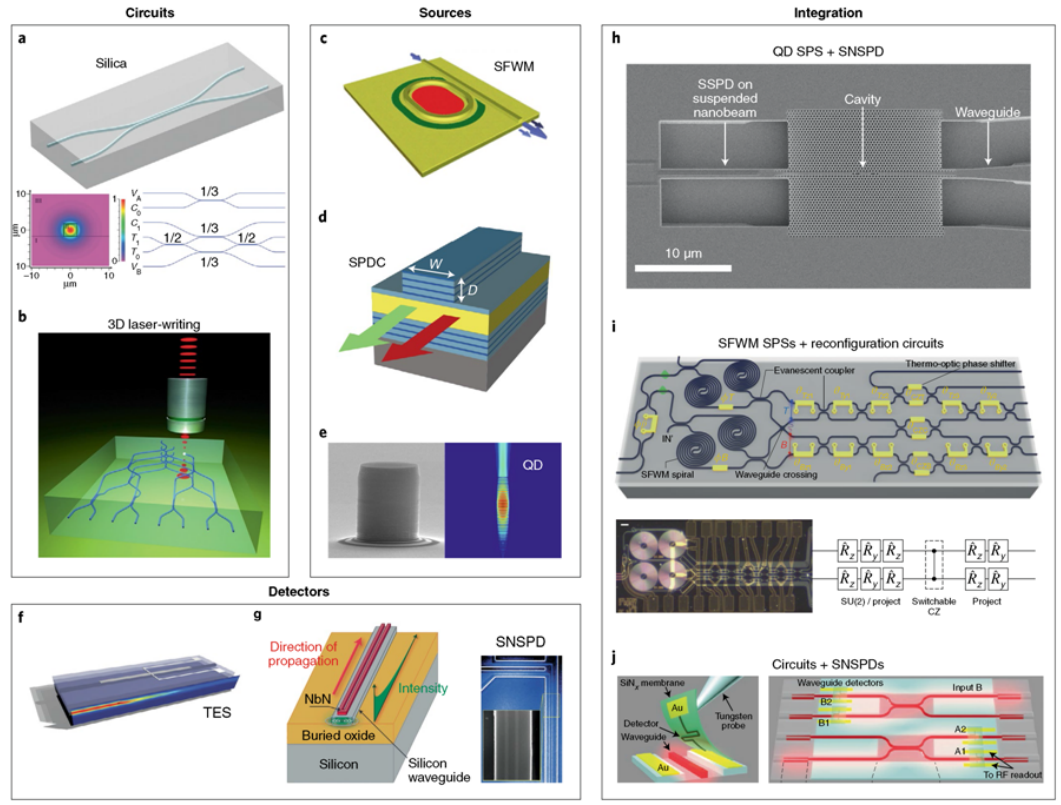
Figure 6. Integrated single-photon sources, detectors, and circuits. ( a ) The first IQP circuit for CNOT entangling gate in silica-on-insulator waveguides. ( b ) Laser writing quantum circuit in silica with complex 3D geometry. ( c ) An integrated SFWM-SPS in Si photonic waveguide. Engineering microresonator enables the generation of highly pure and indistin- guishable photons. ( d ) An integrated SPDC-SPS in GaAs waveguides. A Bragg-waveguide that sustains two different types of eigenmode is engineered to meet the phase matching condition. ( e ) A semiconductor InGaAs/GaAs QD SPS able to emit near-deterministic and highly pure single photons from a single dot embedded in a micropillar. ( f ) An integrated TES SPD that is evanescently coupled to silica waveguides. Up to 5 photons guided in the waveguides can be resolved by the integrated TES. ( g ) An integrated SNSPD atop a Si waveguide that can absorb and detect photons with >90% efficiency.